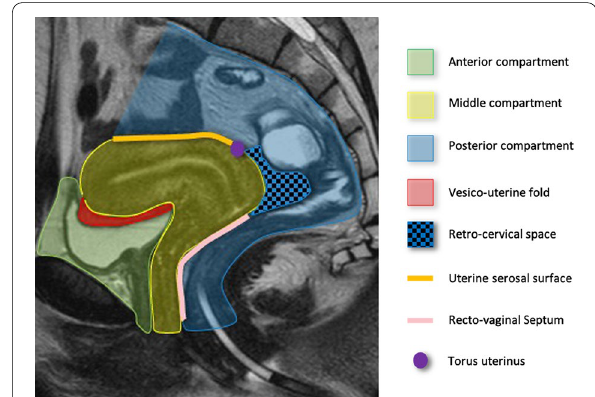
Fig. 3 Midsagittal T2w image of female pelvis with main anatomic landmarks to be considered in the evaluation of